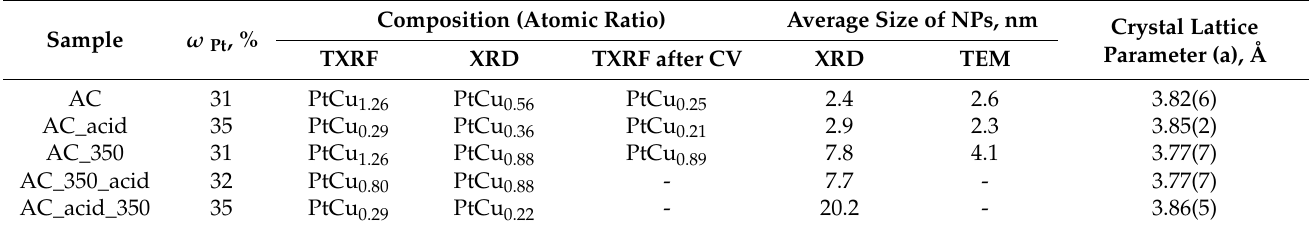
Table 1. Some structural characteristics of the PtCu/C